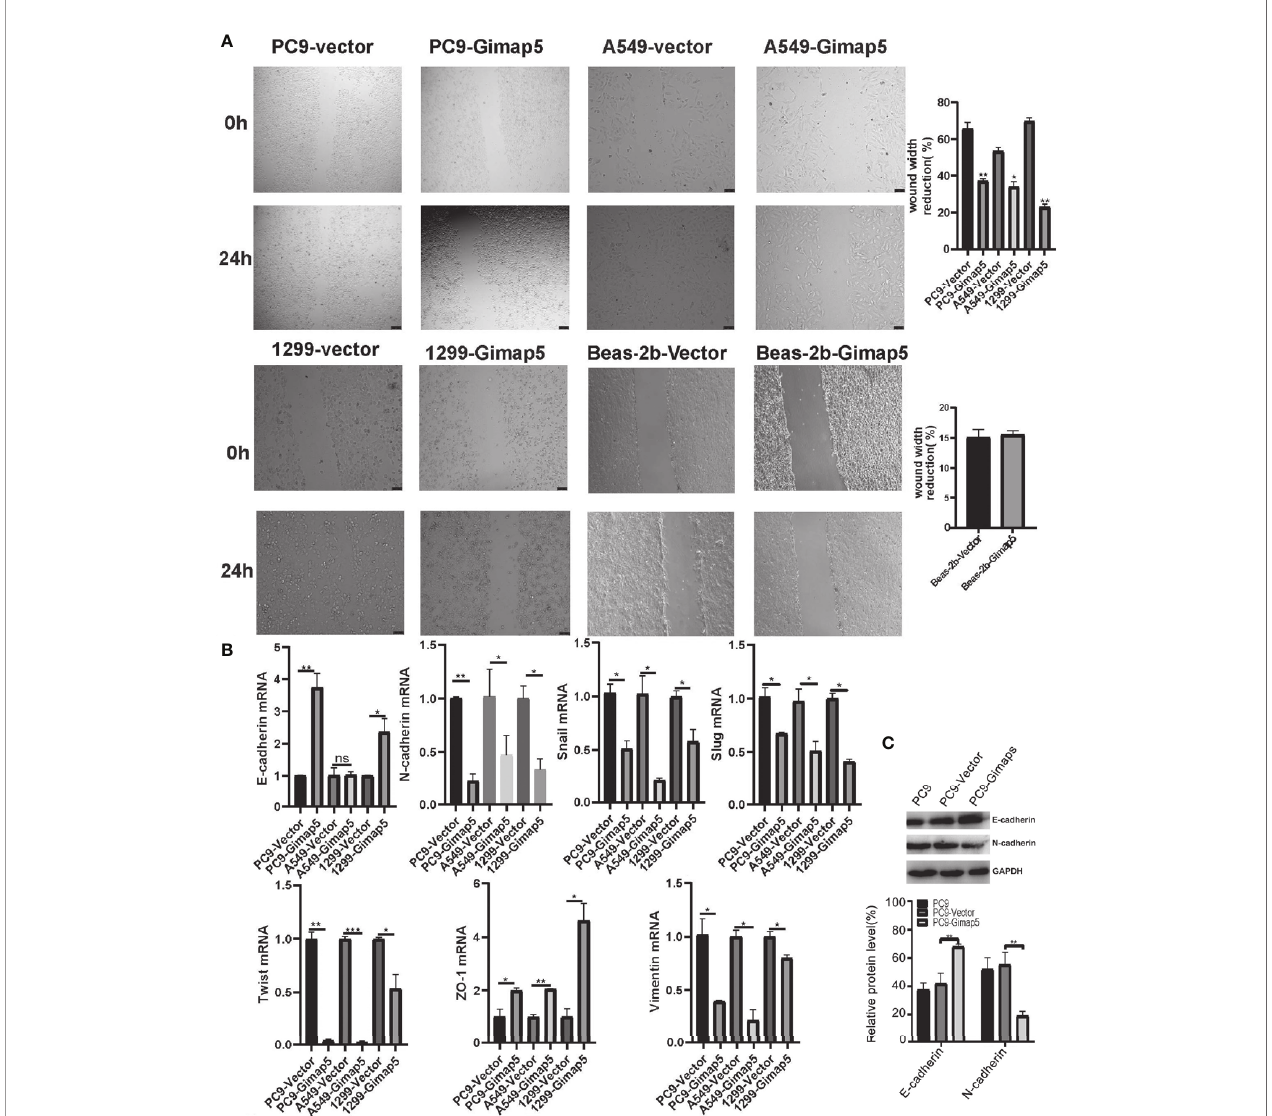
FIGURE 4 | Gimap5 upregulation inhibited migration and EMT (n = 3). (A) Migration speed of PC9, A549, 1299 and Beas-2b cells (magni fi cation, ×100). (B) The mRNA expression levels of EMT-related biomarker were assayed using qRT-PCR, and the data were expressed as mean ± SEM of the three independent experiments. (C) Western blot was used to detect the expression of E-cadherin and N-cadherin proteins in PC9 cells. After the image scanning gray analysis, the internal reference. GAPDH correction was used to obtain the ratio of each group. (ns means no signi fi cance, * p < 0.05 ,** p < 0.01 and *** p < 0.001 vs. empty vector)